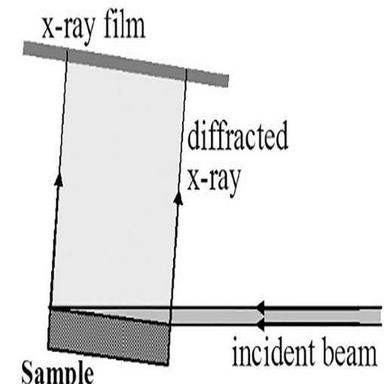
Schematic of the grazing incidence geometry using the synchrotron monochromatic X-ray beam.